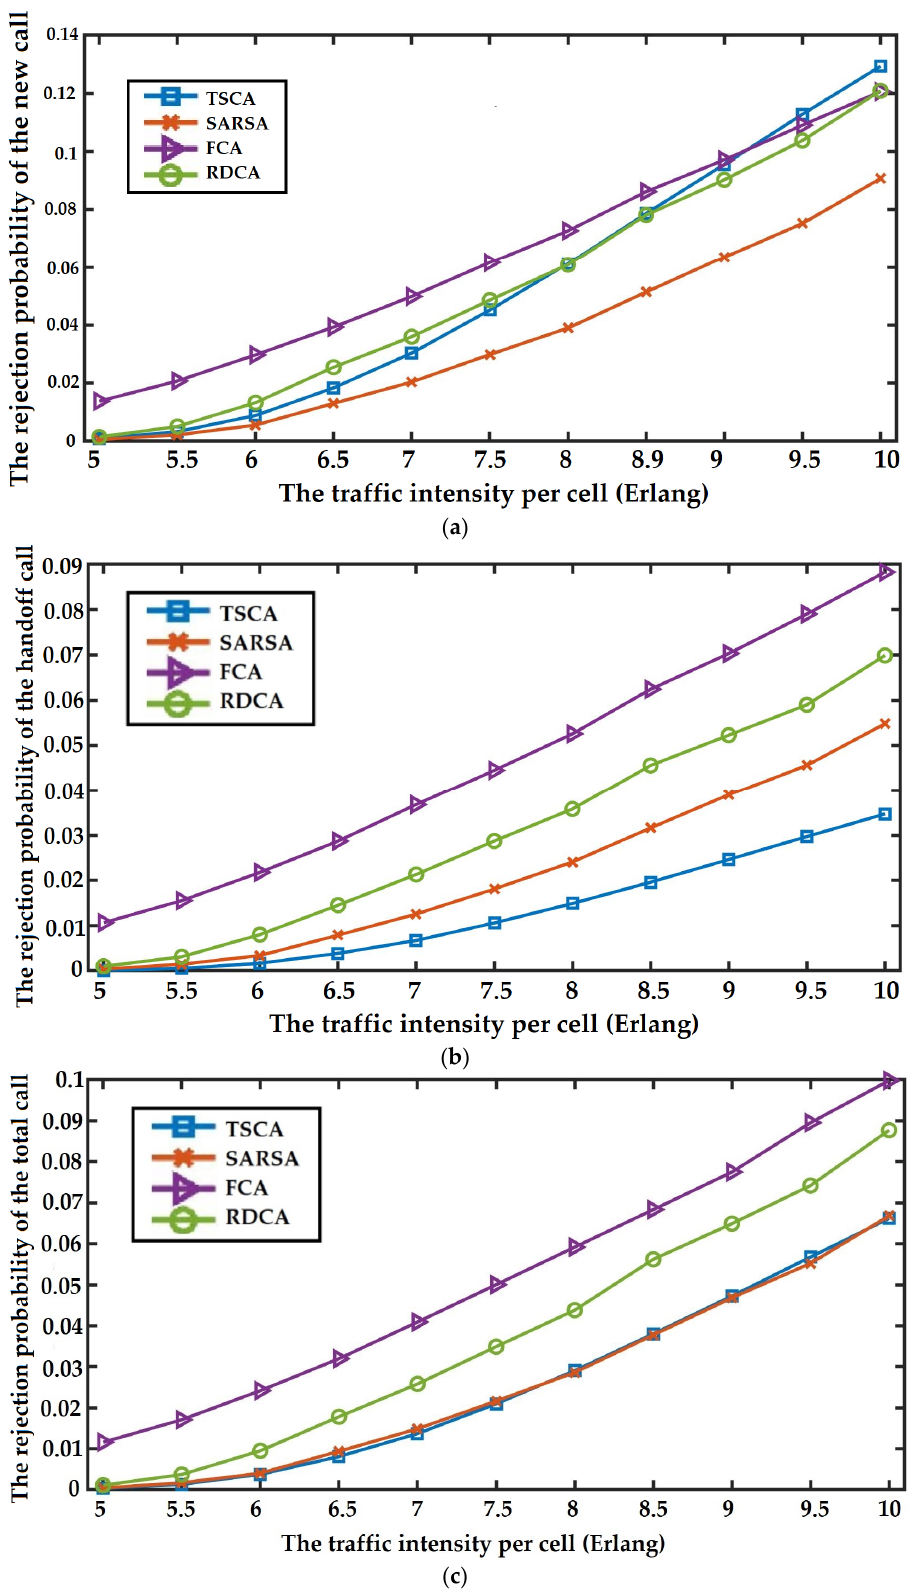
Figure 3. Performance comparison under uniform traffic distributions. ( a ) The rejection probability of the new call; ( b ) the rejection probability of the handoff call; ( c ) the rejection probability of the total